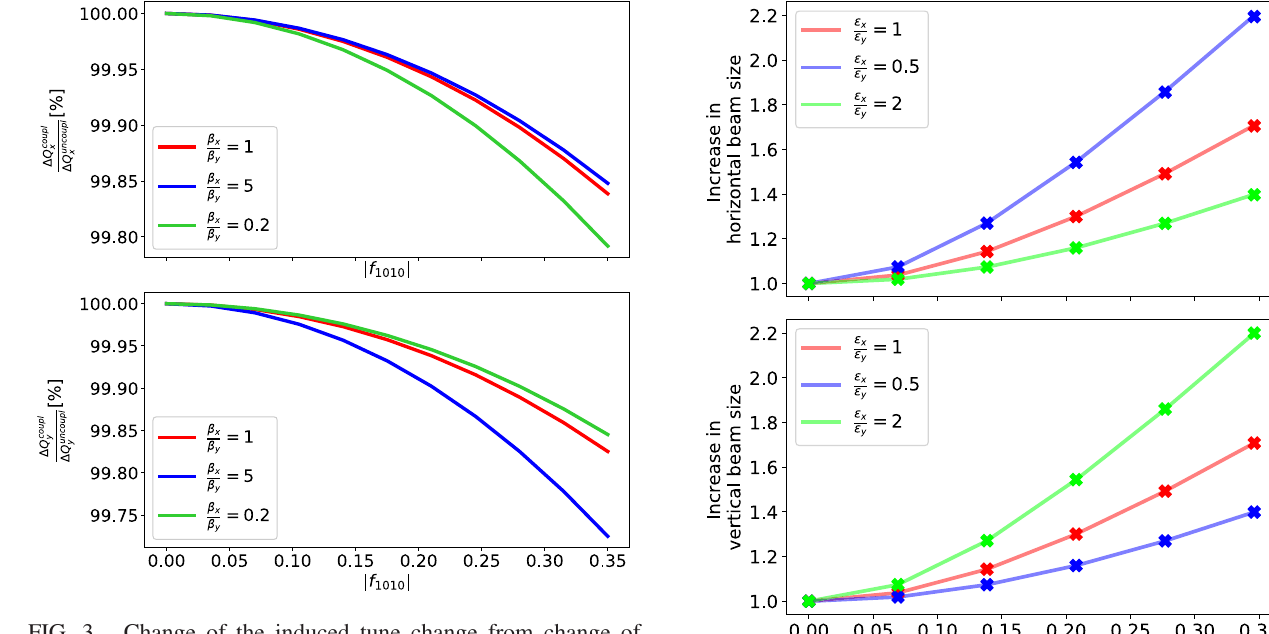
RDT.FIG. 3. Change of the induced tune change from change of quadrupole gradient with local coupling